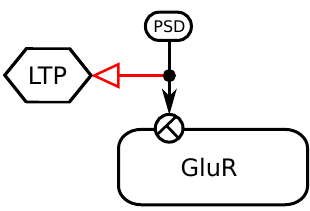
Figure 2.22: Example of a stimulation a phenotype “Long Term Potentiation (LTP)” en- hanced when the entity “GluR” is present in the post-synaptic